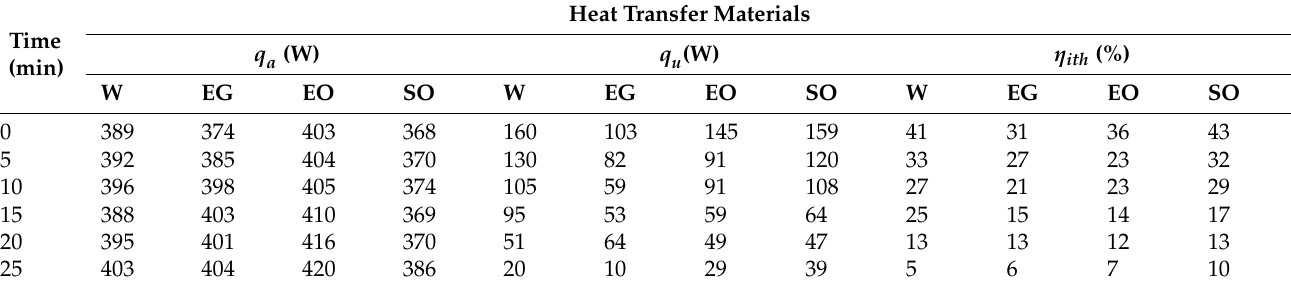
Table 4. Instant thermal efficiency of